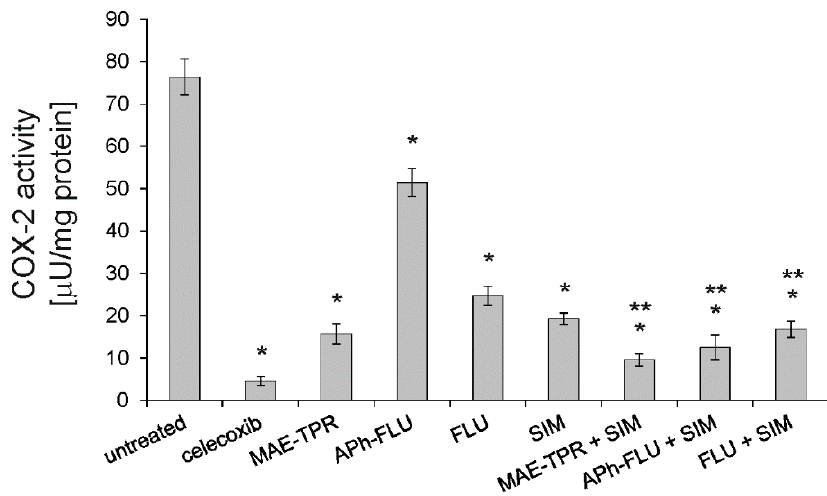
Figure 6. COX-2 activity in LoVo/Dx cells treated with phenothiazine derivatives, simvastatin (SIM) and phenothiazine derivatives in combination with simvastatin. Means of three experiments ± SD are presented. The statistically significant differences from the untreated LoVo/Dx control were determined using Student’s t -test (* p < 0.05). The statistically significant differences between the samples containing phenothiazine derivative as a single agent and samples with phenothiazine derivative combined with simvastatin were also determined using Student’s t -test (** p < 0.05).